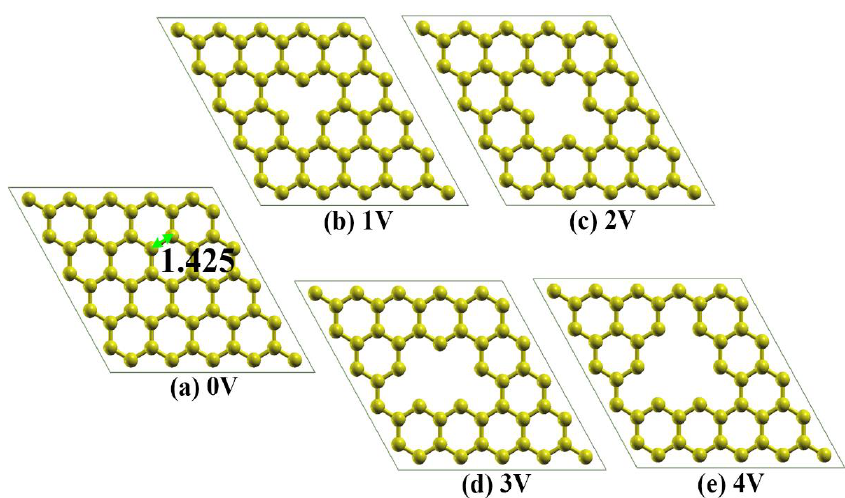
Figure 1. The basic structure of graphene for CO 2 gas adsorption: ( a ) represents the pristine graphene (0V); ( b – e ) represents the carbon deficiency varying from monovacancy (1V), divacancy (2V) and trivacancy (3V) to tetravacancy (4V). The black numbers in the images represent the bond lengths.